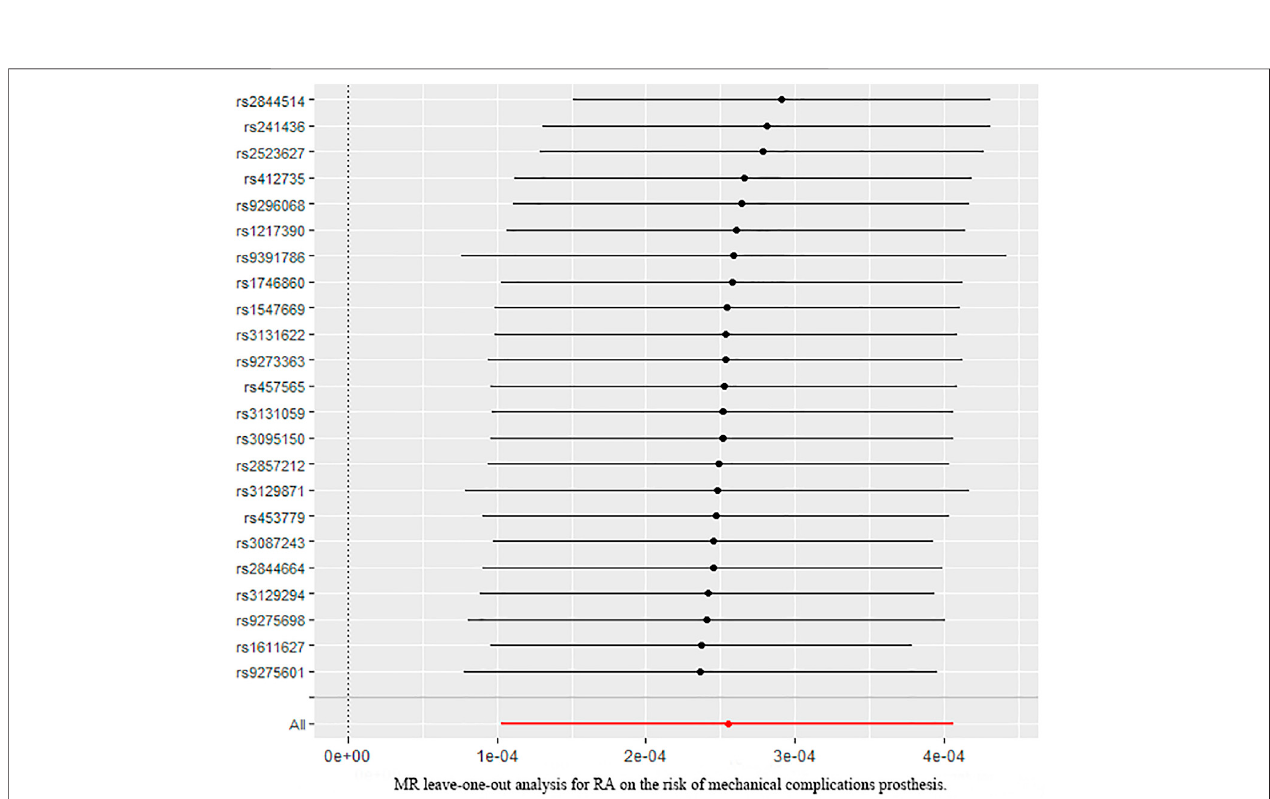
FIGURE 4 | Leave-one-out analysis plots for RA on the risk of mechanical complications of prosthesis.